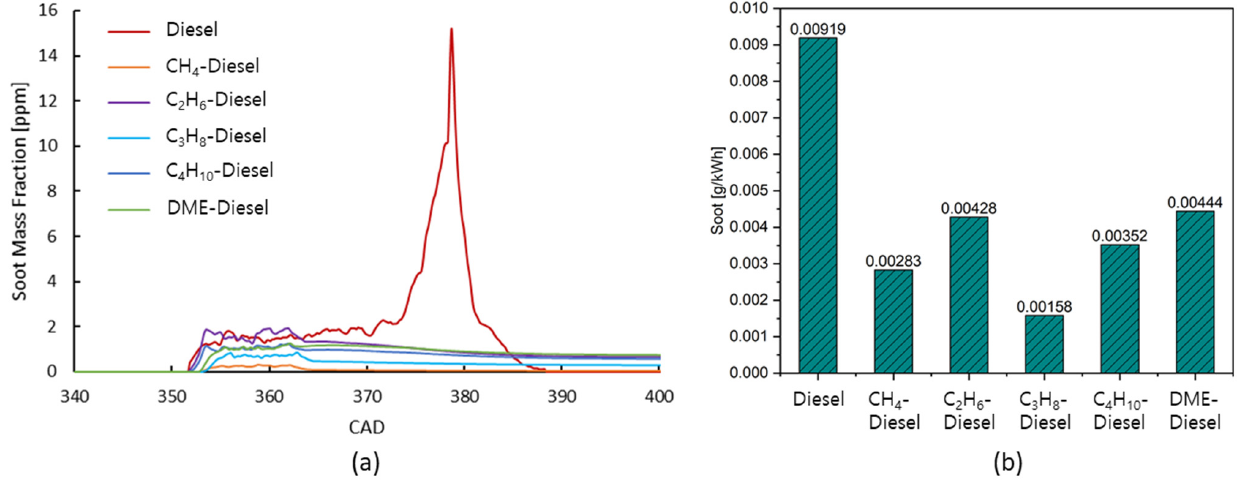
Figure 15. Mean soot mass fractions ( a ) and soot emission masses ( b ) in all combustion cases